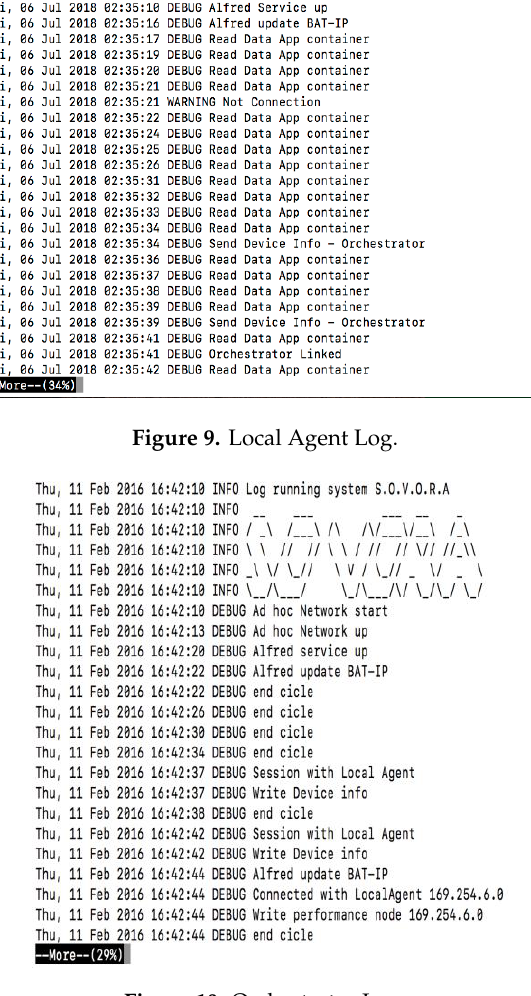
Figure 10. Orchestrator Log.